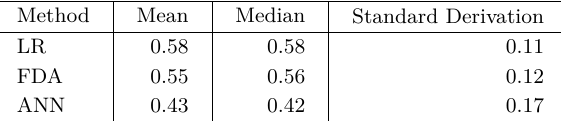
Table 2. Statistics (mean, median & standard deviation) for all the three methods using imbalanced